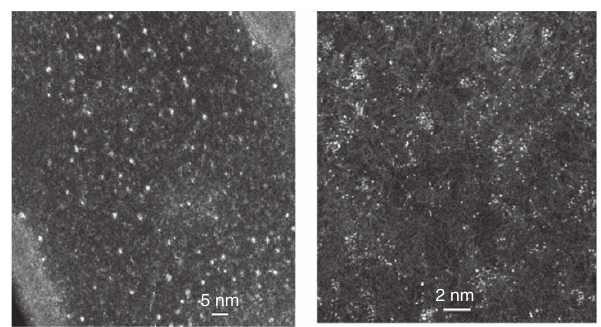
Figure 4 | Aberration-corrected electron microscopy images of filtrates. TEM images of filtrate from Au/SiO 2 -A collected after conversion reached 18%. The filtrate was diluted with ethanol and dried on the grid. Scale bar, 5nm and 2nm for the left and right images.